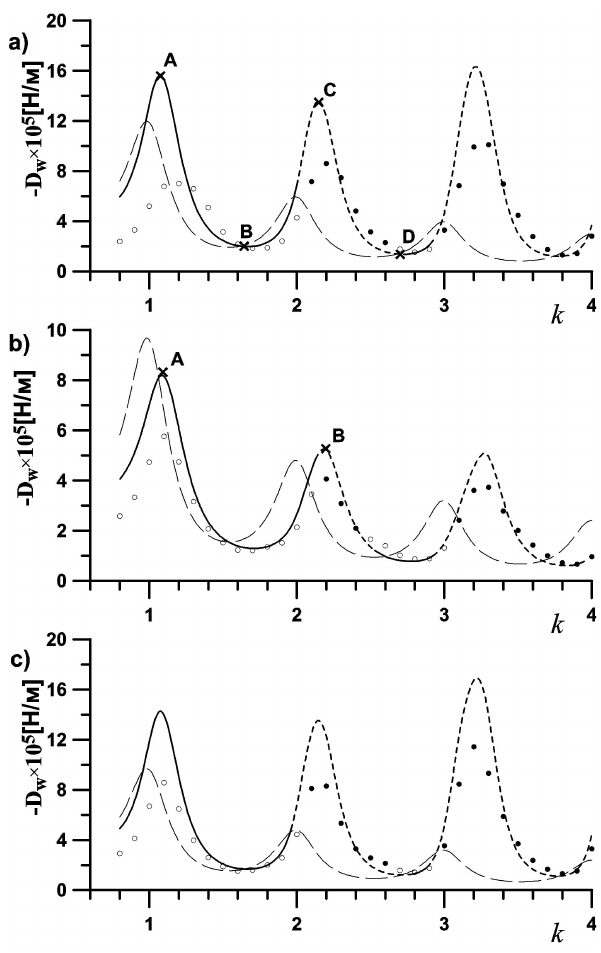
Fig. 4. Wave drag as a function of k for (a) , Ural, and (b) , (c) , Scandinavian mountains. Notations are the same as in Fig. 3. For each case, the results for D W , based on the linear drag coefficient, Eq. (45), are also plotted as dashed